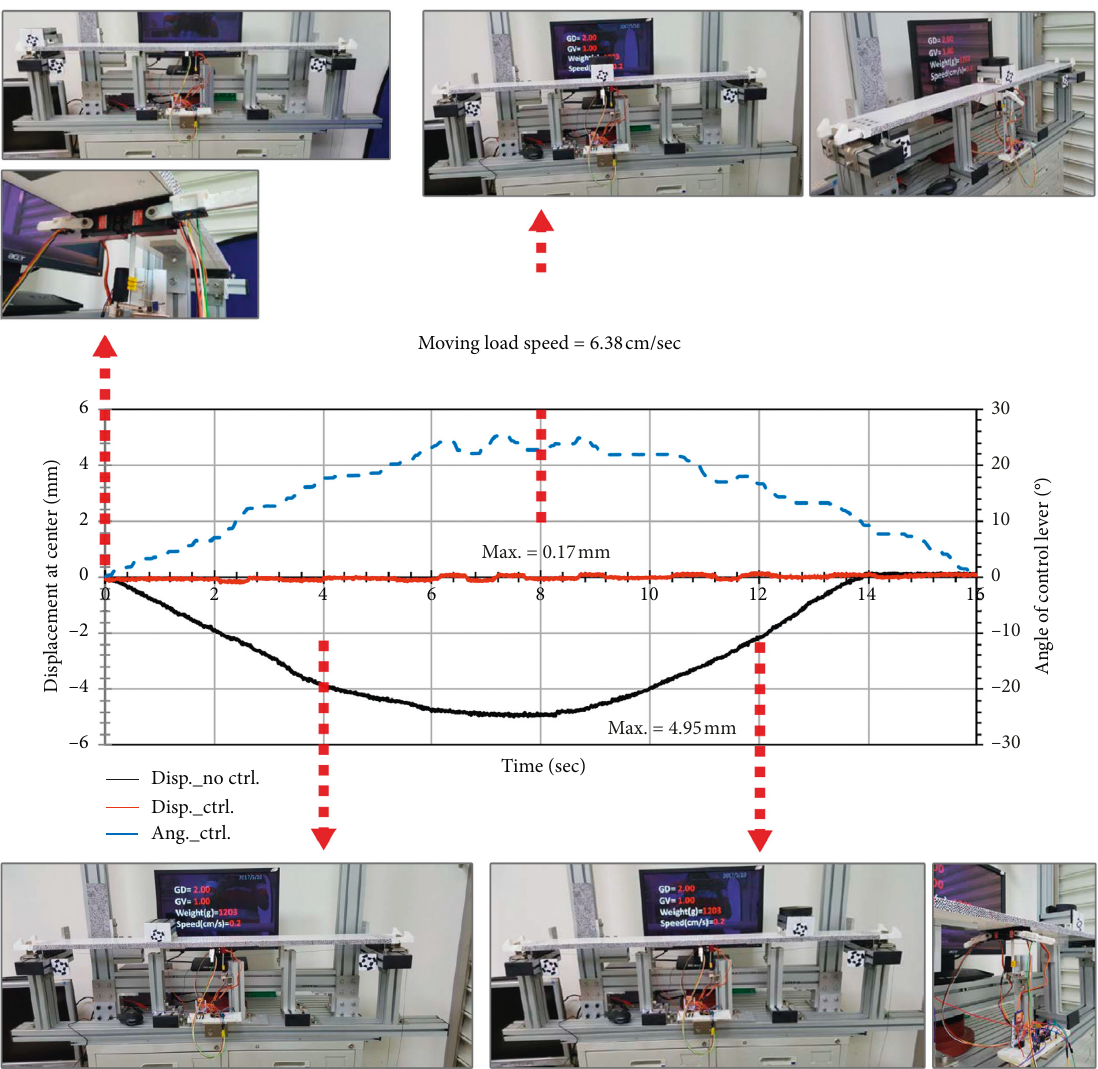
Figure 11: Comparison of the displacement control effects of a bridge without control and with NEM control and rotation angle variations of the bridge with NEM control at the midpoint of the